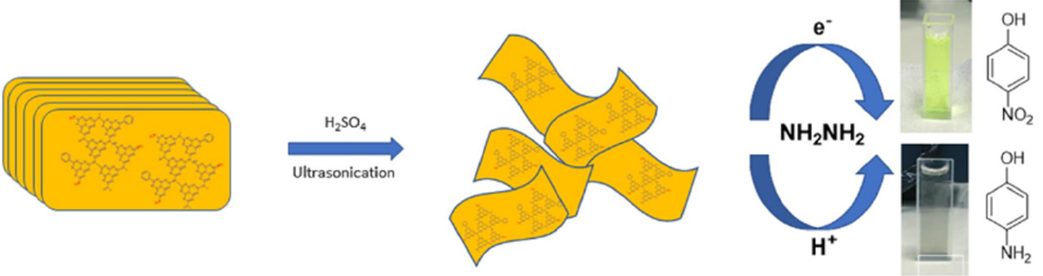
Figure 8. 4 − Nitrophenol reduction using protonated and exfoliated phenyl carbon nitride (pePhCN) as photocatalyst [97].